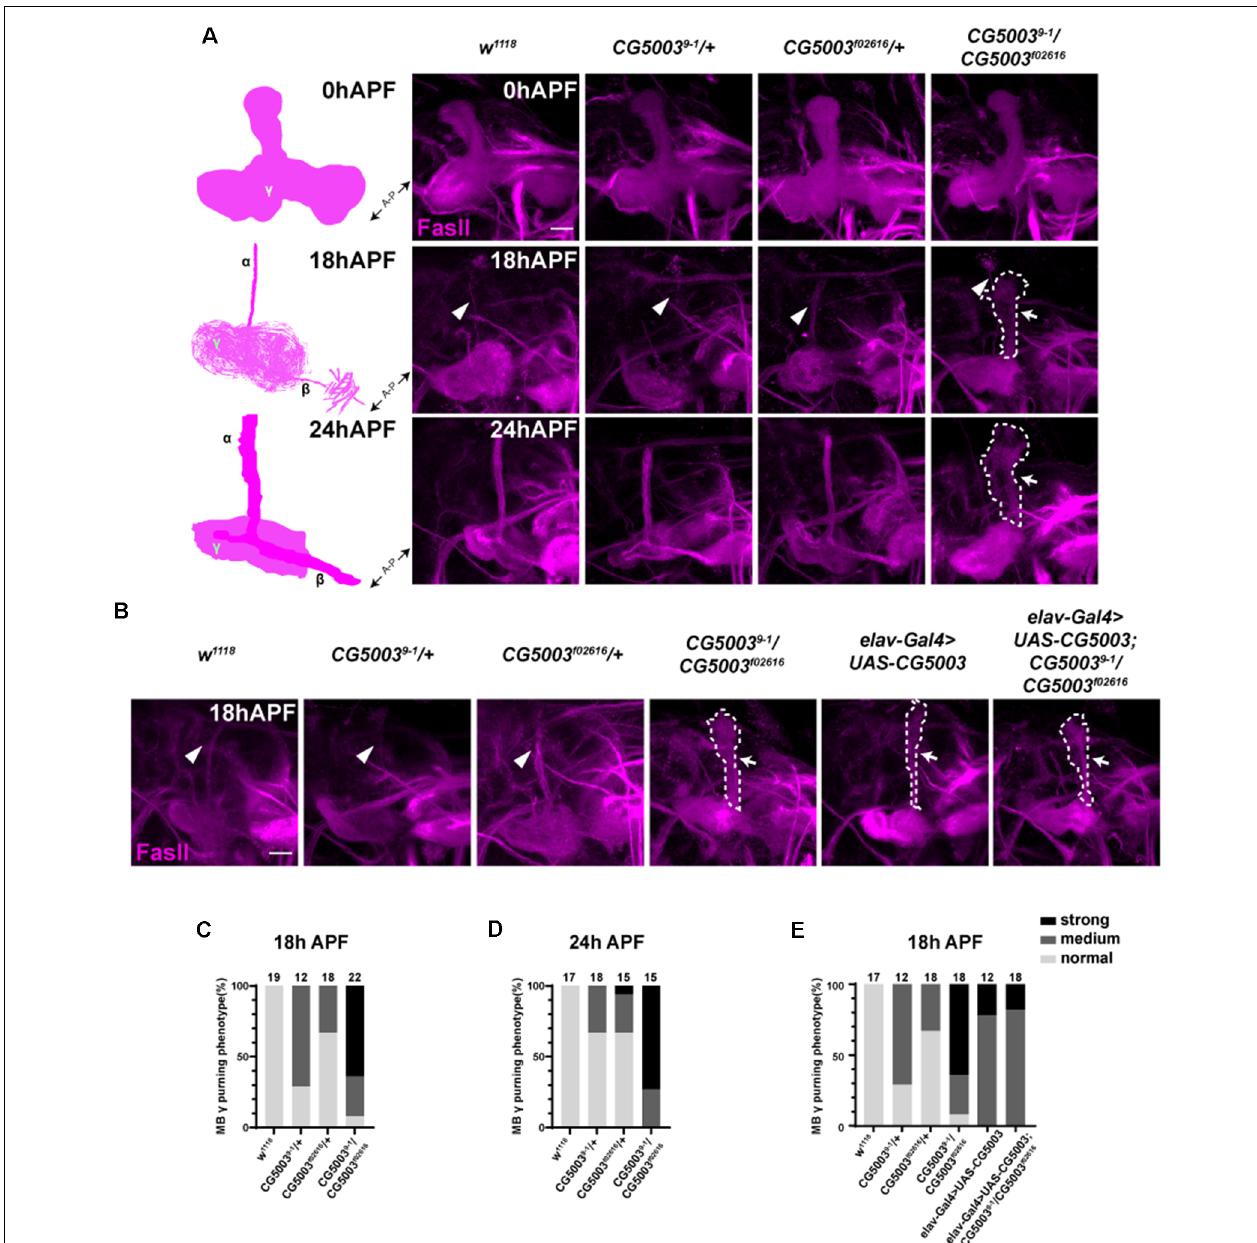
FIGURE 2 | CG5003 mutants exhibit mushroom body (MB) γ axon pruning defects. (A–E) Representative confocal images (A,B) and quantifications (C–E) of MB γ lobe formation of control and CG5003 mutant fly brains at different developmental stages: 0 h APF, 18 h APF, and 24 h APF. Note that FasII-positive γ lobes are left unpruned at 18 h APF and 24 h APF in CG5003 mutant MBs. elav driven CG5003 expression partially rescued the mutant pruning defects. White arrows and dashed lines encircle the area of unpruned γ lobes. White arrowheads indicate the vertical α lobes. The N number of brains dissected and quantified for